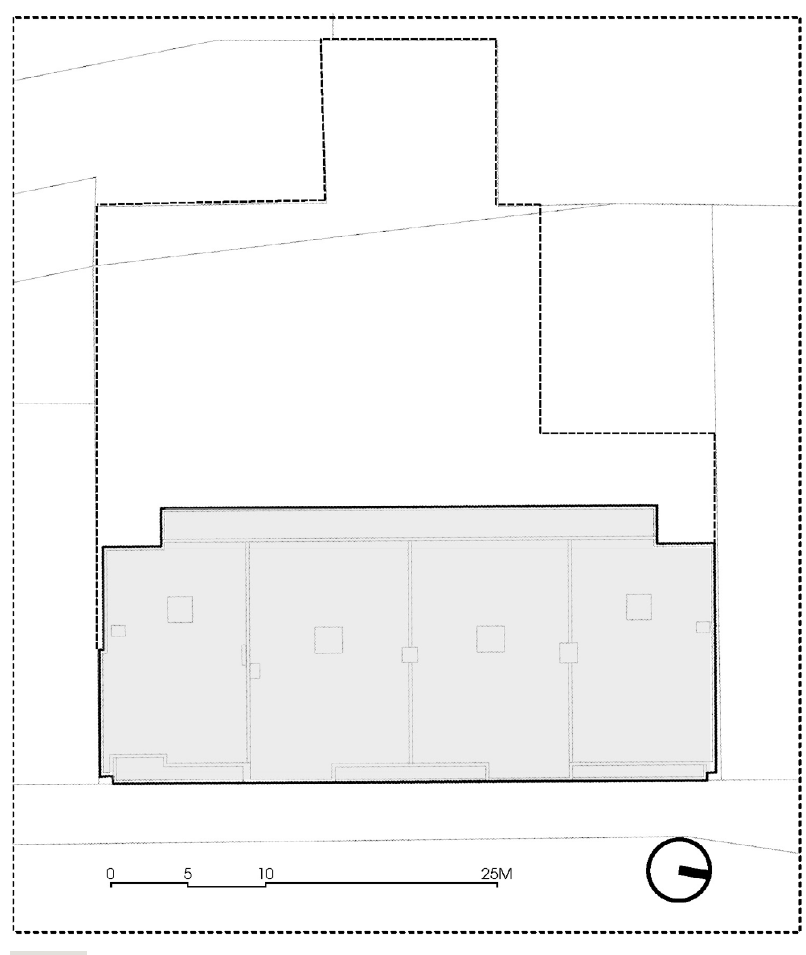
The building where Leo lives, is located on the street. The residents have their parking lots at the back of the